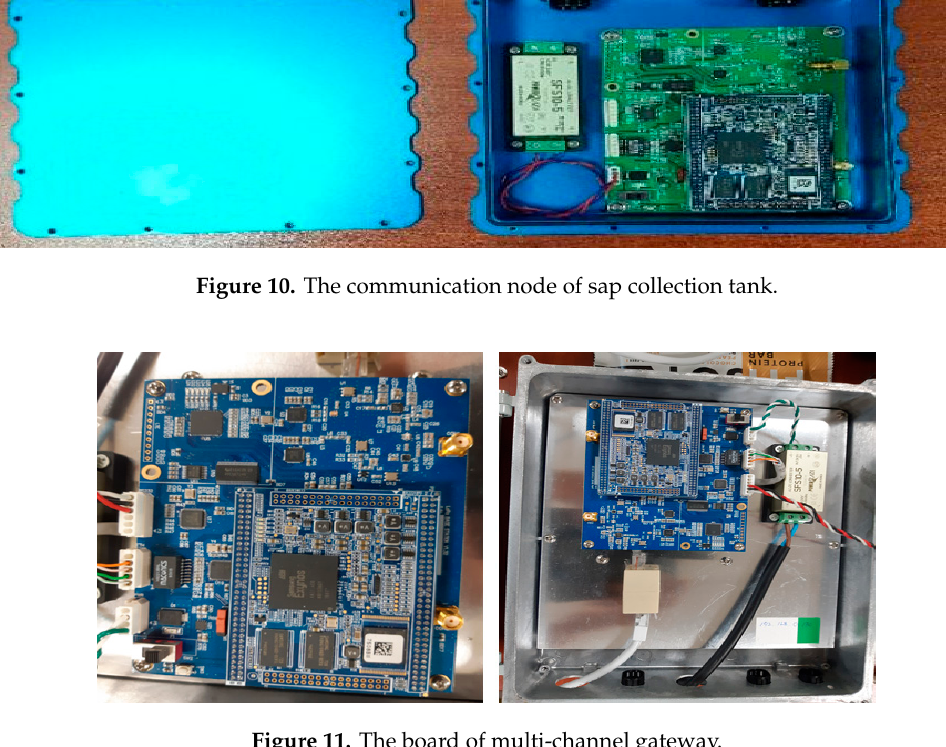
Figure 10. The communication node of sap collection tank.